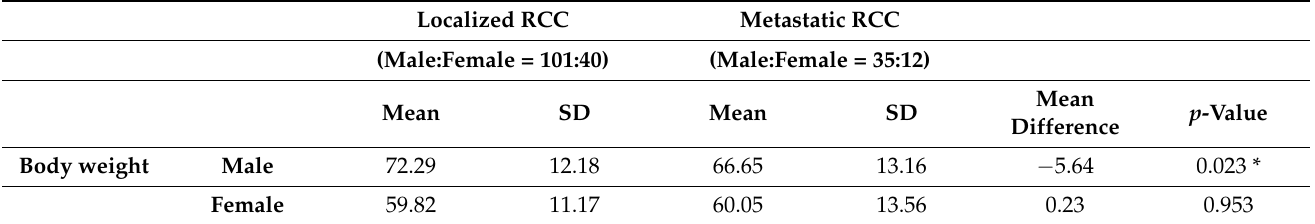
Table 3. Subgroup Analysis Between Localized and Metastatic